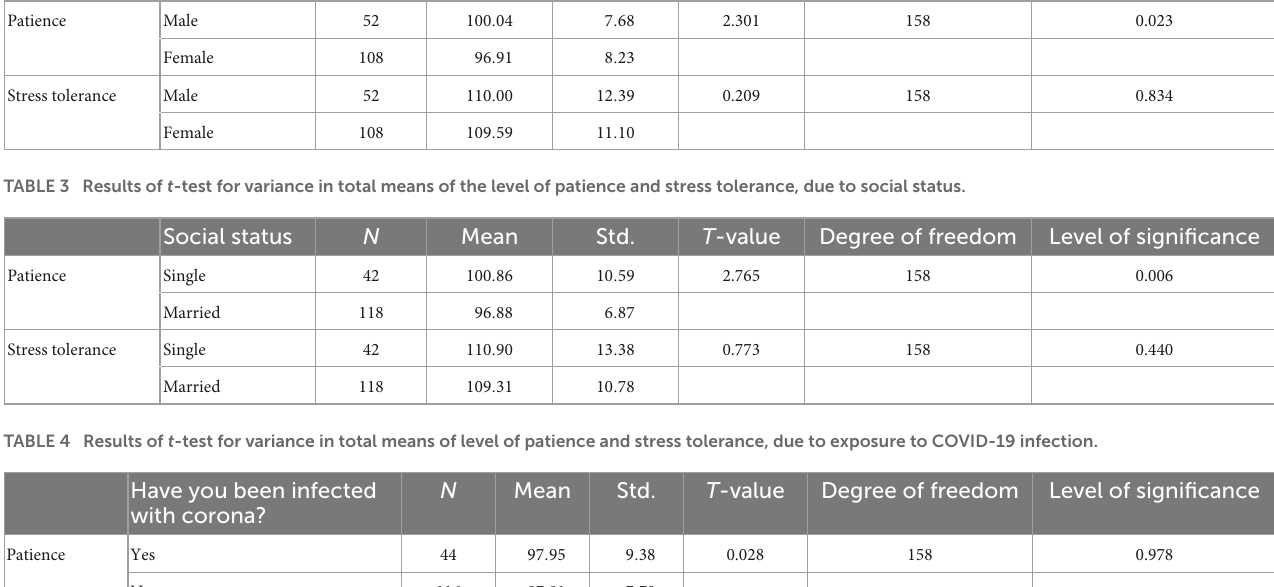
TABLE 1 Results of simple linear regression to examine the effect of patience on stress tolerance. Correlation coefficient Inflection coefficient Slope of the regression line T -value signification level Statistical significance 0.478 TABLE 2 Results of t -test for variance in total means of the level of patience and stress tolerance, due to gender. Gender N Mean Std. T -value Degree of freedom